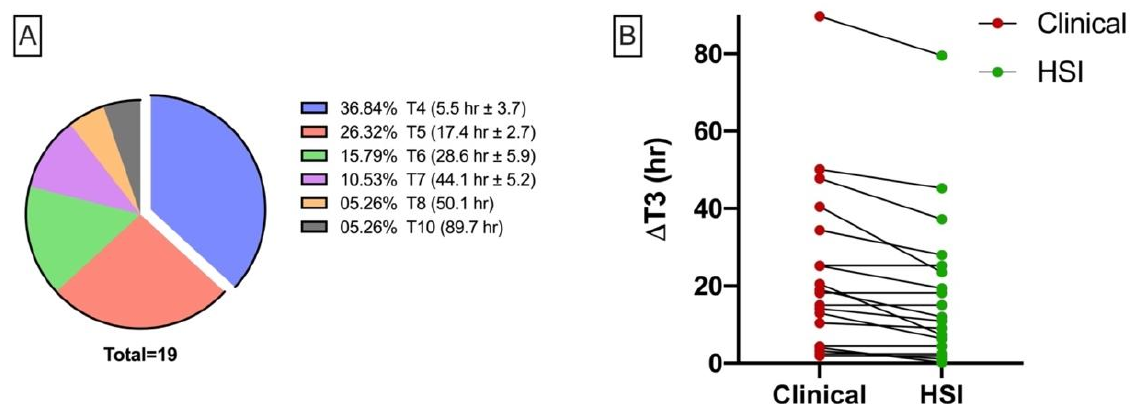
Figure 9. ( A ) Pie chart showing actual duration to clinical manifestation of flap malperfusion and subsequent re-exploration with associated time interval. ( B ) Aligned dot plot shows duration (h) from flap insertion to clinical (left) and hyperspectral detection of flap malperfusion.